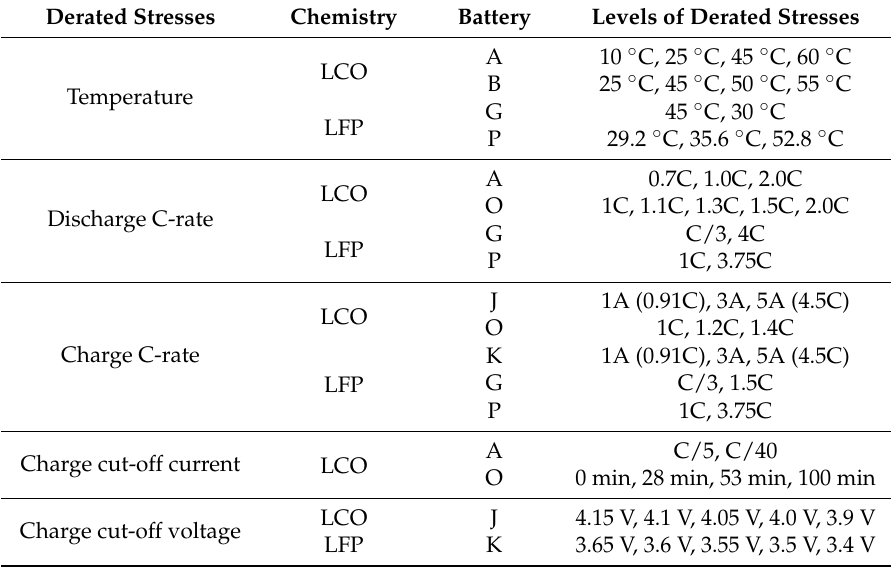
Table 2. Battery samples and derated stresses